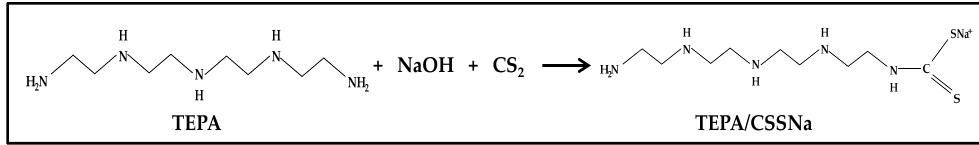
Figure 1. Scheme of the synthesis of the dithiocarbamate ligand-TEPA/CSSNa.